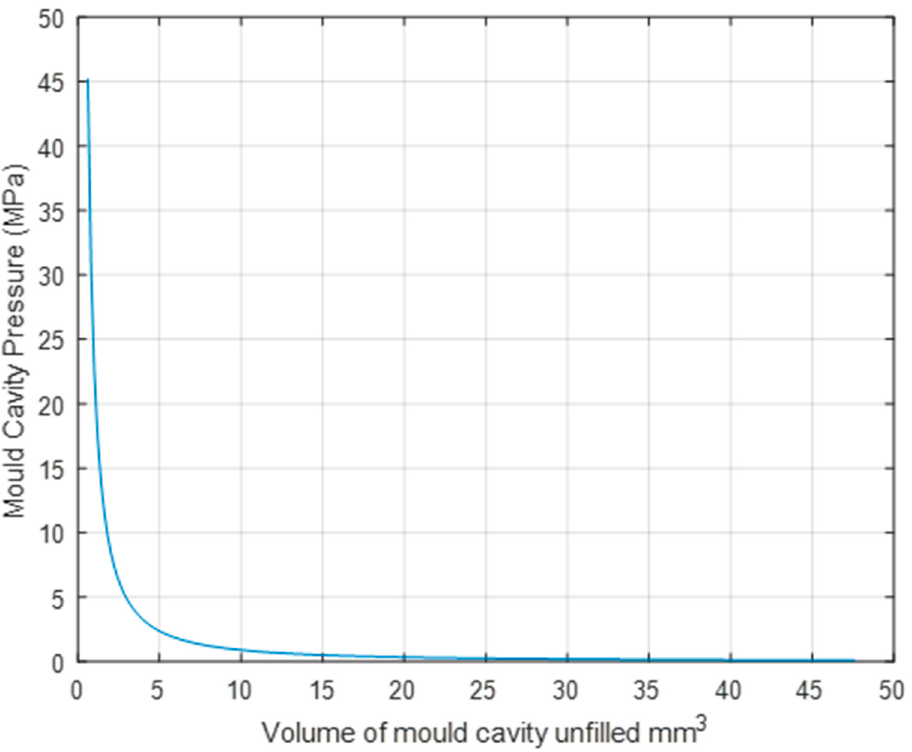
Micromachines 2020 , 11 , 358 Figure 6. Pressure increase when air is compressed in mould. Figure 6. Pressure increase when air is compressed in mould.